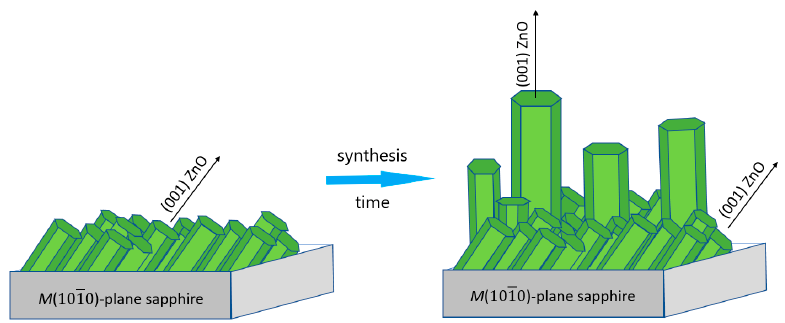
Figure 3. Proposed growth scheme for hybrid ZnO structure.